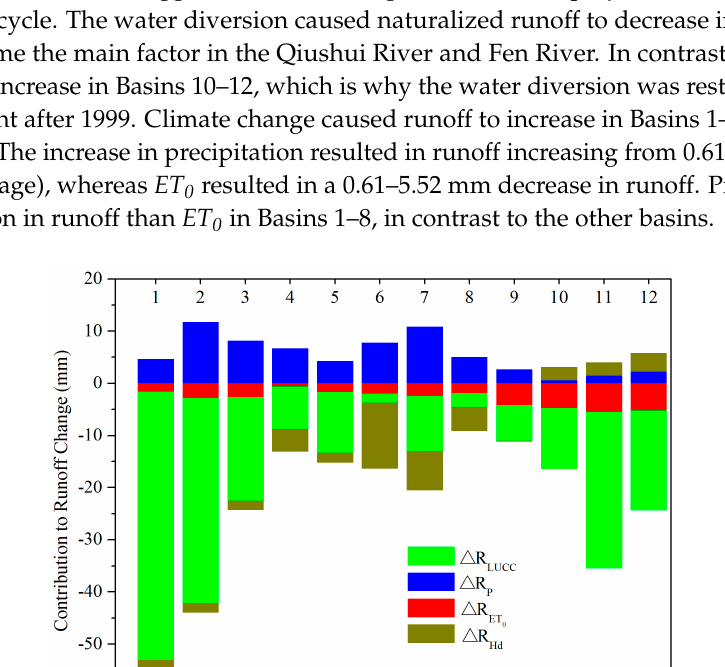
Table 4. Land use/cover change (LUCC) in 1990 and 2010 in the Loess